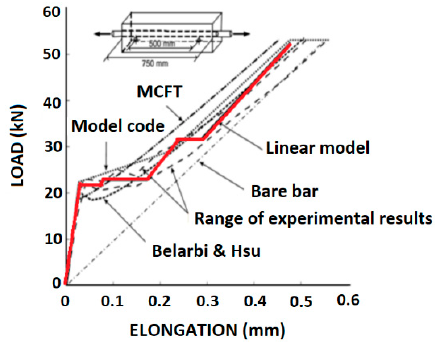
Figure 10. Comparison of Hartl’s test results with different models.